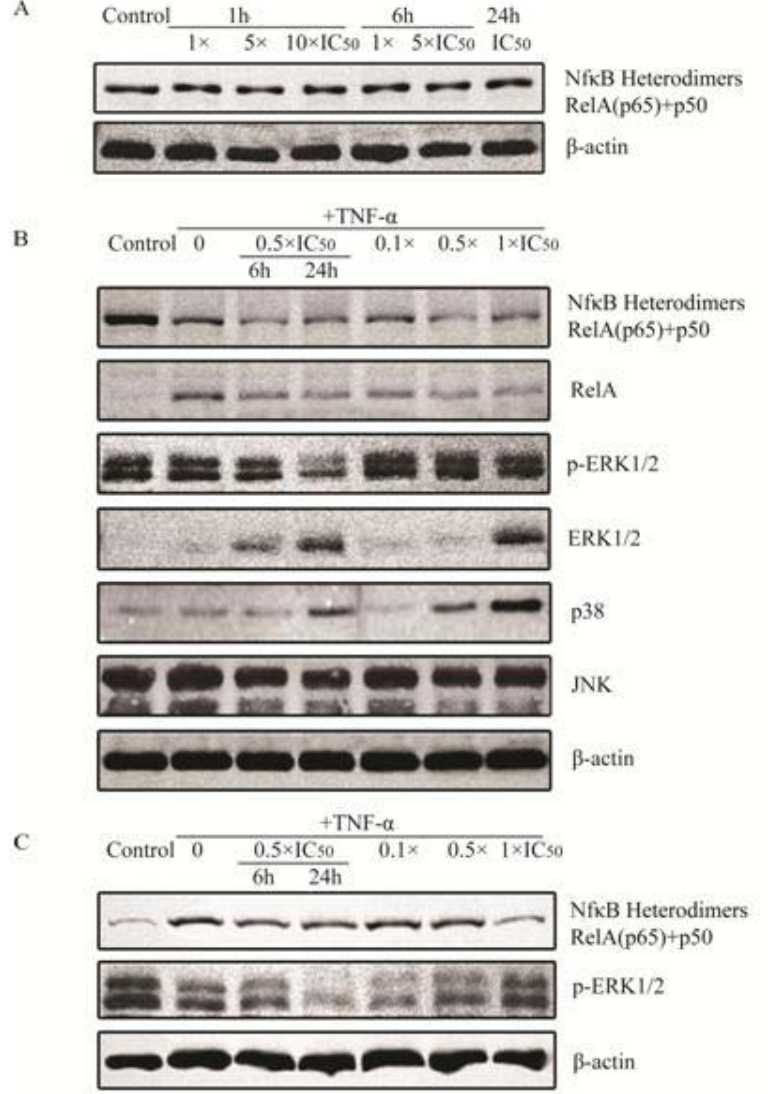
Figure 4. Signaling profile of the MAPK family in HaCaT cells treated with Radix Scrophulariae ningpoensis as measured by Western blot